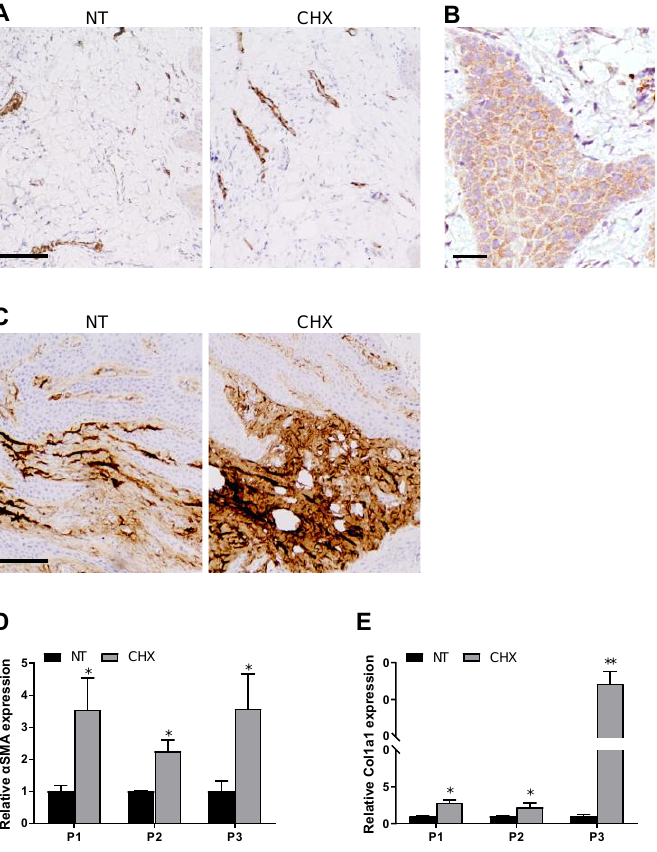
Figure 2. CHX increases protein and mRNA expression of fibrotic markers α SMA and Col1A1 in gingival tissues. ( A ) Representative photomicrographs of sections of NT and CHX gingival biopsies stained with anti- α SMA. Scale bar 100 µ m. ( B ) Representative photomicrograph of cytoplasmic staining for α SMA in the epithelial layer observed in CHX biopsies. Scale bar 25 µ m. ( C ) Representative photomicrographs of sections of NT and CHX gingival biopsies stained with anti-Col1a1 antibodies. Scale bar 100 µ m. ( D , E ) Quantitative real-time PCR analysis of α SMA ( D ) and Col1a1 ( E ) mRNA expression in NT and CHX biopsies of three patients. Relative mRNA levels are shown as fold value of the NT levels. mRNA levels were normalized to GAPDH mRNA expression. Each experiment was performed in triplicate. Error bars represent standard deviations. * p < 0.05 and ** p < 0.005 vs. NT.